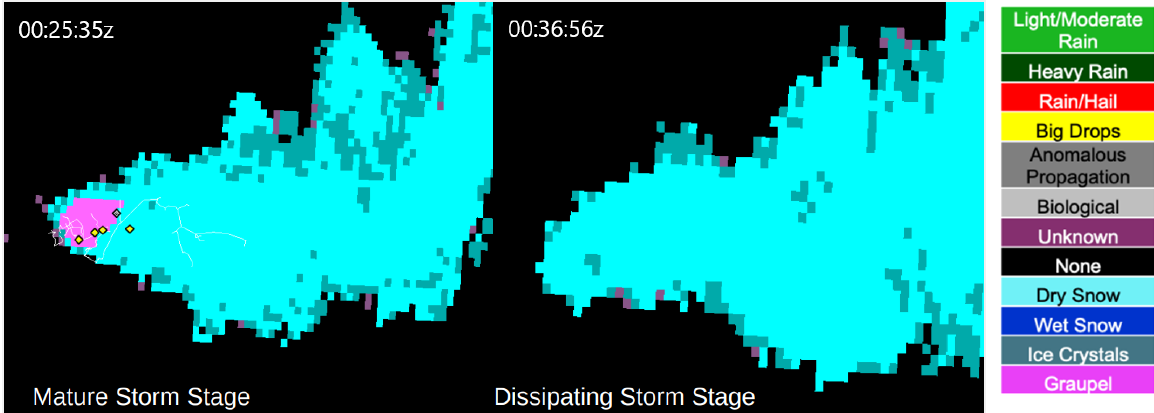
Figure 3. The HCA displays the most likely hydrometeor type based on a combination of polarimetric radar products. These two panels show the dissipation of graupel at −10 °C in a non-severe, isolated storm on 22 June 2016. The yellow diamonds represent the initiation location of flashes detected by the DCLMA within 1 min of the radar time stamp.